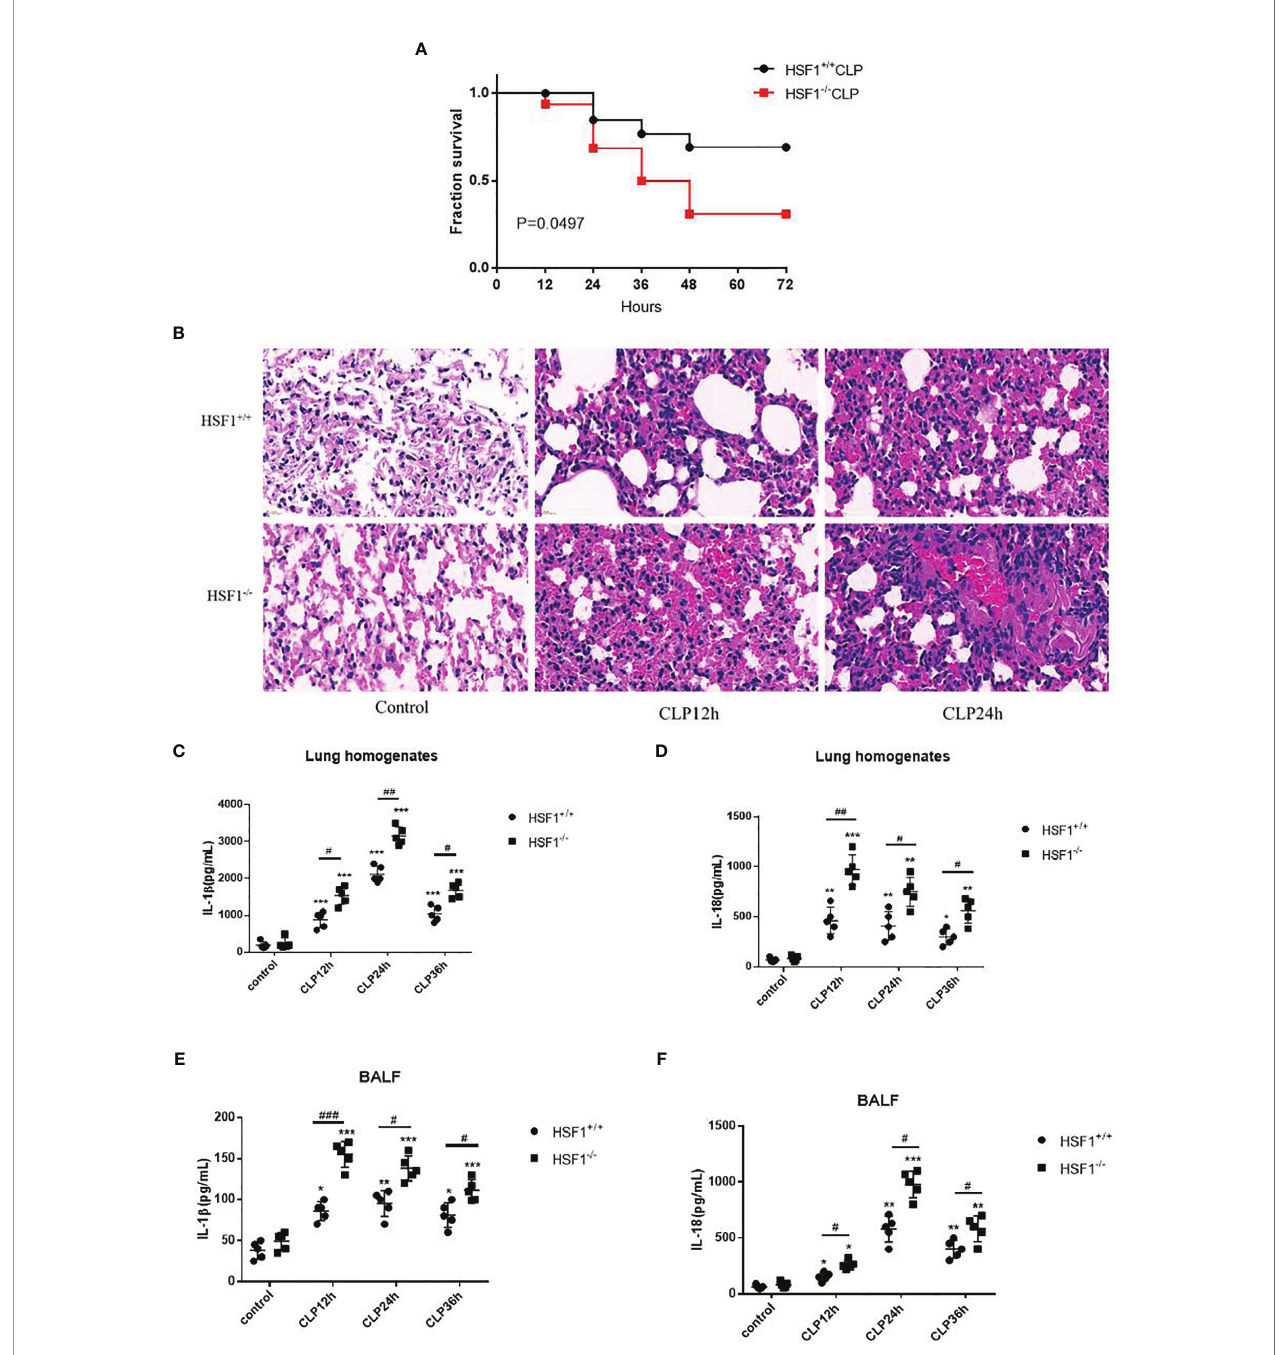
FIGURE 1 | HSF1 ameliorates pulmonary in fl ammation in sepsis-induced ALI. (A) The survival rate of HSF1 − / − and HSF1 +/+ mice after CLP. (B) After 12- and 24-h CLP interventions, representative pictures of lung tissue sections were stained with H&E. (C – F) The expression of IL-1 b and lL-18 in lung homogenate and lung BALF after CLP operation was monitored by ELISA. Data are representative or means (SD) of at least three independent experiments. Statistical analyses were determined using a Student ’ s t -test and one-way ANOVA. *p < 0.05, **p < 0.01, ***p < 0.001 versus control group; # p < 0.05, ## p < 0.01, ### p < 0.001 versus HSF1 +/+ CLP group. ALI, acute lung injury; CLP, cecal ligation and puncture; BALF, bronchoalveolar lavage fl